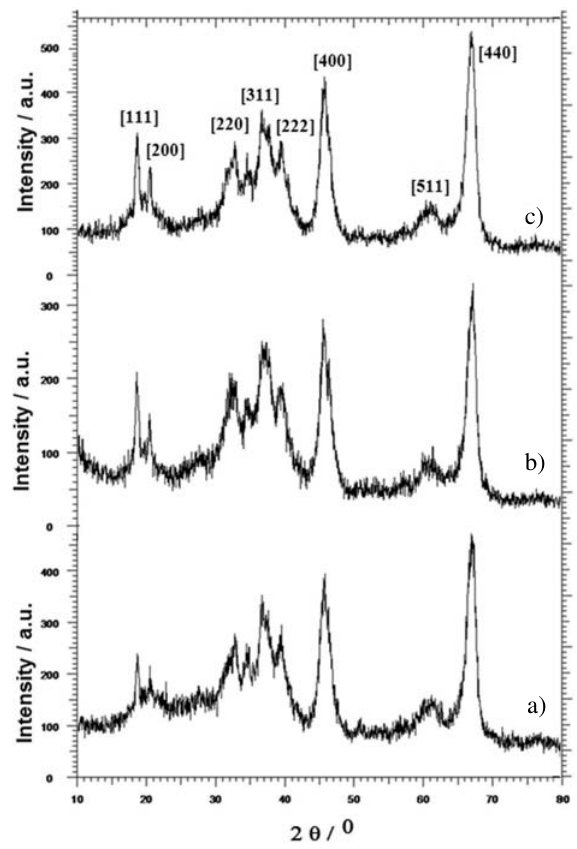
Fig. 1: XRD diffraction patterns of: (a) Al modified by oleic acid; (c) Al